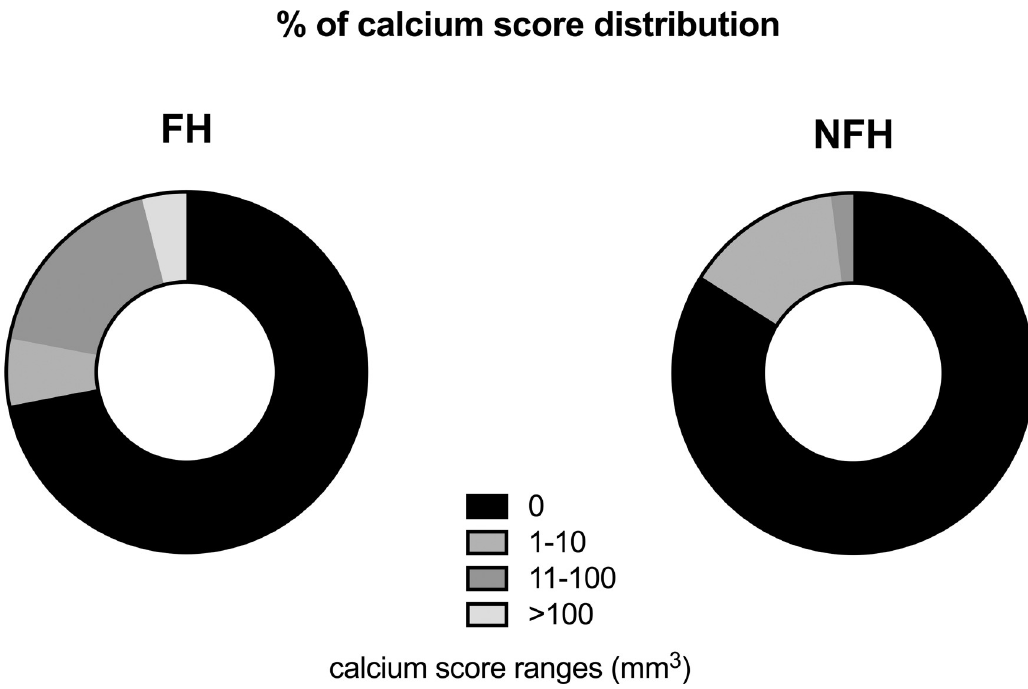
Fig 3. Calcium score distribution across AVCS in LDLR-M and LDLR-WT groups. Data in particular ranges are expressed as % of each calcium score subgroup. Abbreviations: LDLR-M–patients with familial hypercholesterolemia and LDLR mutation, LDLR-WT–nonfamilial hypercholesterolemia, AVCS—aortic valve calcium score.